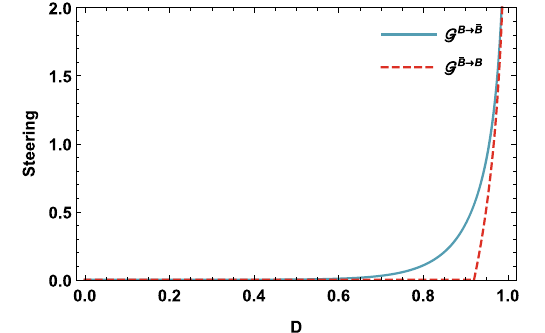
¯ B ¯ B → B and G as a func- Fig. 4 The Gaussian steerability asymmetry between B and ¯ B as a function of the dilaton parameter D . The initial squeezing parameter, massparameterandfrequency ω arefixedas s = 1, M = 1and ω = 0 . 5